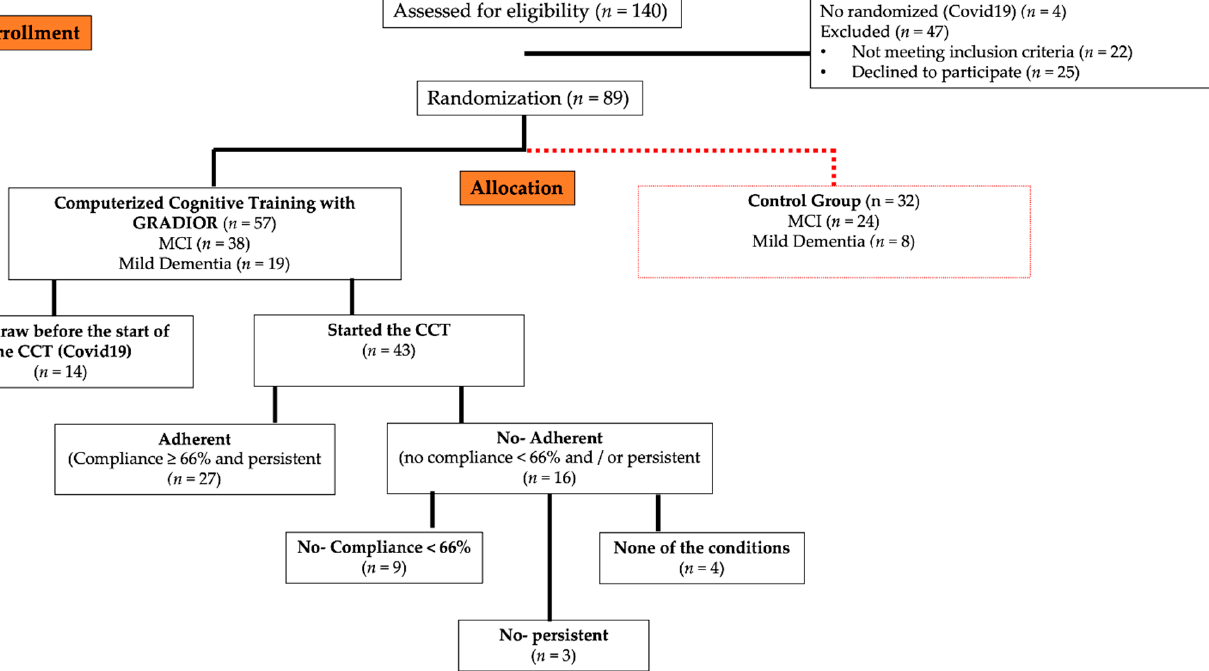
Figure 2. Sample randomization process of randomized clinical trial (RCT). Additionally, conformation of the adherent and non-adherent group in the experimental group (EG). CCT, Computerized cognitive training.